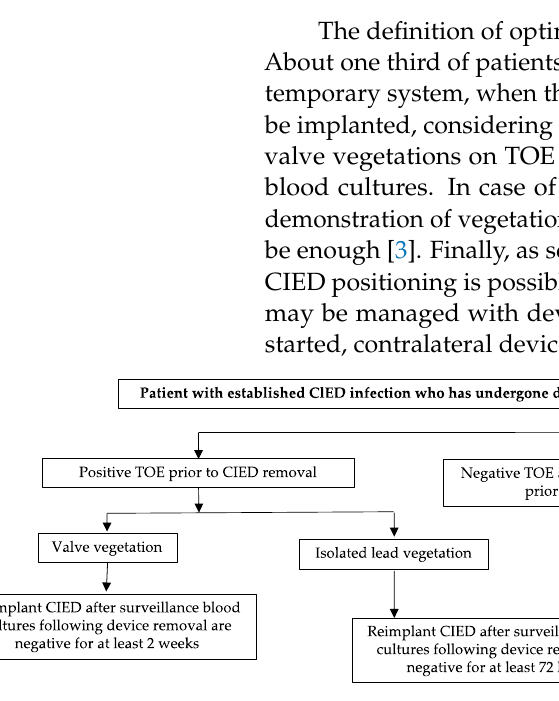
Figure 5. Proposed algorithm for optimal re-implantation timing in patients with persistent indication to CIED. CIED: cardiovascular implantable electronic device; TOE: trans-oesophageal echocardiography. Different devices as subcutaneous ICDs (S-ICDs) or leadless PMs may also be taken into account to reduce the risk of relapses